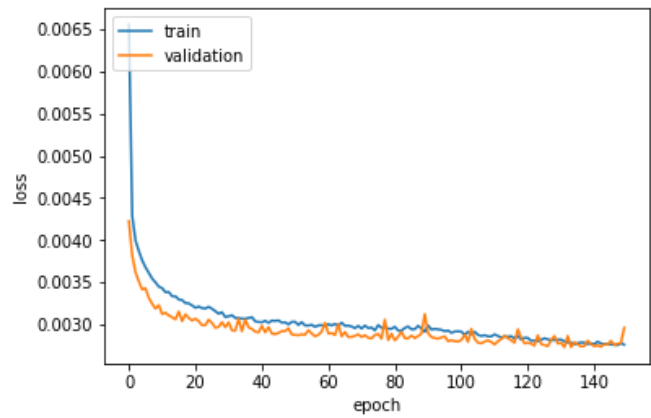
Figure 22. Neural network model loss performance, based on mean squared error (MSE).